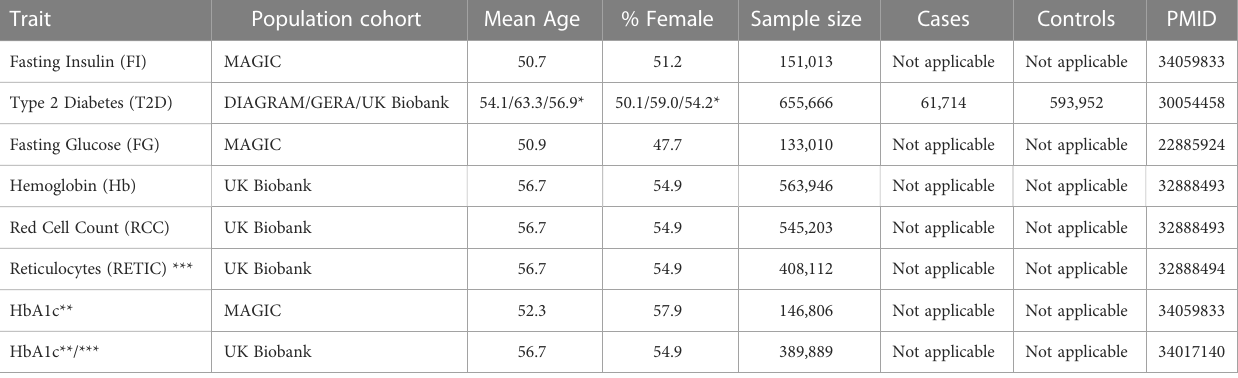
TABLE 1 Cohort details for Mendelian Randomization (MR)